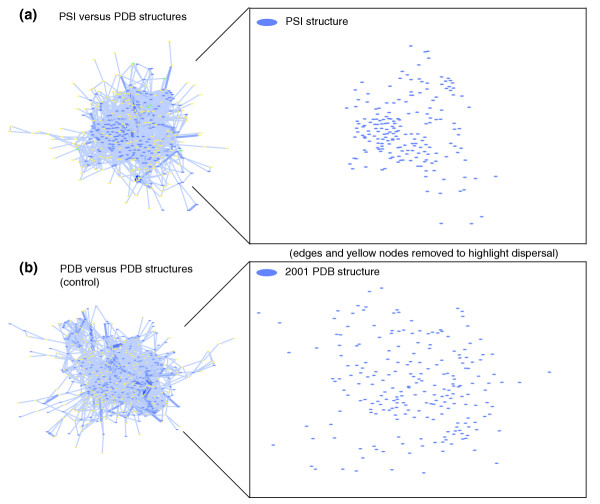
Structure publications linked by Medical Subject Headings (MeSH) terms. (a) All available primary citations for Protein Structure Initiative (PSI) structures (shown in blue) were compared with primary citations from a random set of 300 Protein Data Bank (PDB) structures (shown in yellow). Blue color nodes are segregated into tight clusters, indicating close similarity among PSI structures. Yellow nodes are relatively interspersed because of fewer common edges, indicating greater variability in connecting MeSH terms. Out of a total of 860 MeSH terms associated with PSI structure nodes (435 of which are unique), the term 'Bacterial proteins - chemistry' is the most common, connecting a clique of 52 nodes. (b) As a control, two random sets of 300 PDB structures were chosen from a set of 3,112 structures released in 2001-2002 that included a primary citation available in PubMed. Those sets of citations were then run through PubNet as Query1 and Query2. Nodes of both colors are fairly well interspersed. The PDB structure nodes carry 1,247 MeSH terms (861 unique), the most common of which is also 'Bacterial proteins - chemistry', but it only connects a clique of 16 nodes.